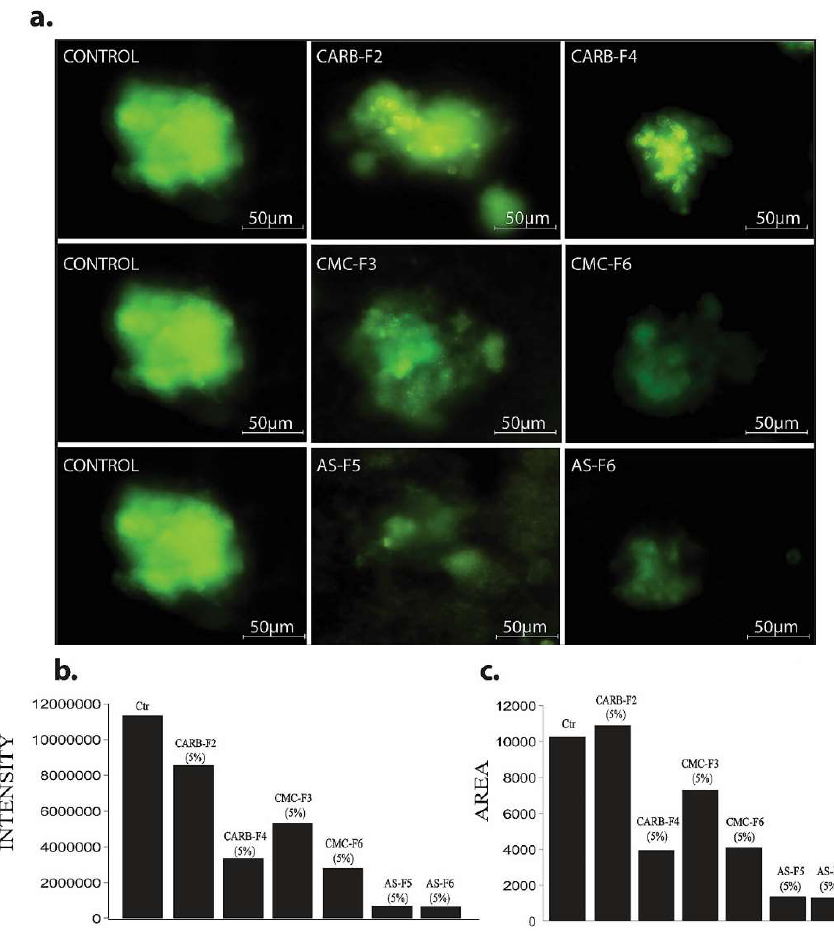
Figure 7. ( a ) 3D Matrigel assay for human melanoma cell cultures in standard conditions (left) and in